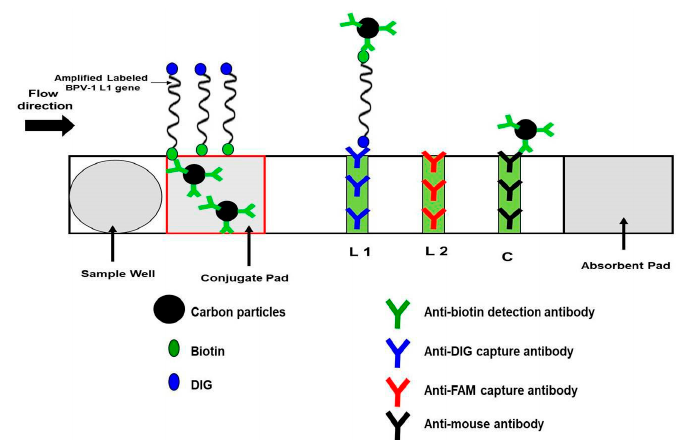
Figure 3. PCRD cassette. The carbon-conjugated biotin antibodies at the conjugate pad bind to biotin of the BPV-1 L1 gene amplicons and flow towards L1 and L2. L1 is lined with anti-DIG monoclonal antibodies to bind the labeled amplicons. L2 is decorated with anti-FAM monoclonal antibodies and will remain free from any carbon particles. C line is the control line that is lined with anti-mouse antibodies and will capture excess carbon-conjugated biotin.